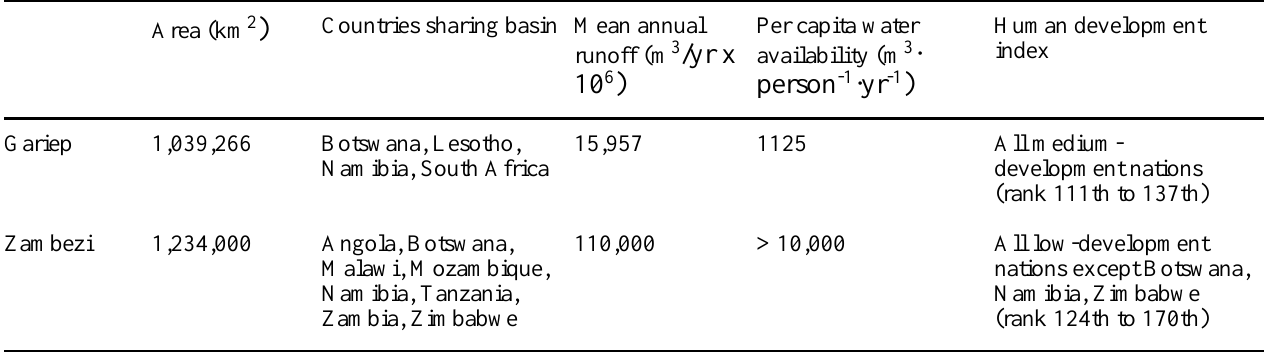
Table 1. Characteristics of the Gariep (M. D. Watson, personal communication ) and Zambezi (Snaddon et al. 1999, area and mean annual runoff; Revenga et al. 1998, per capita water availability) basins. Human development index figures are from UNDP